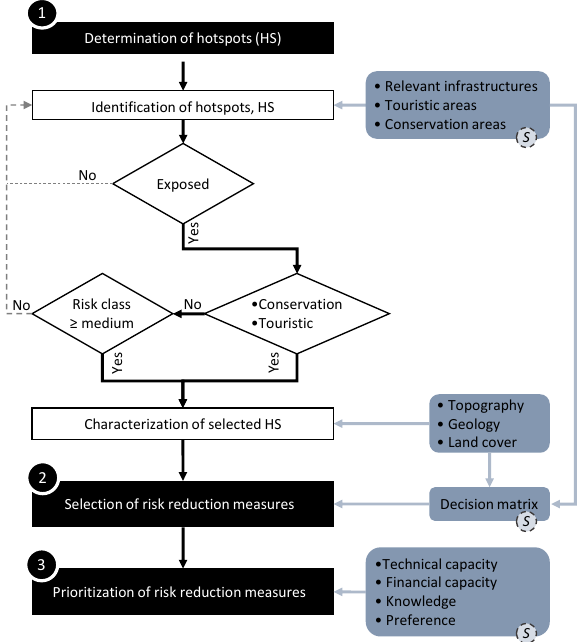
Figure 6. Scheme of the methodology for the prioritization of rec- ommended tsunami risk reduction measures ( S : participation of stakeholder panel of local and international experts on coastal and risk